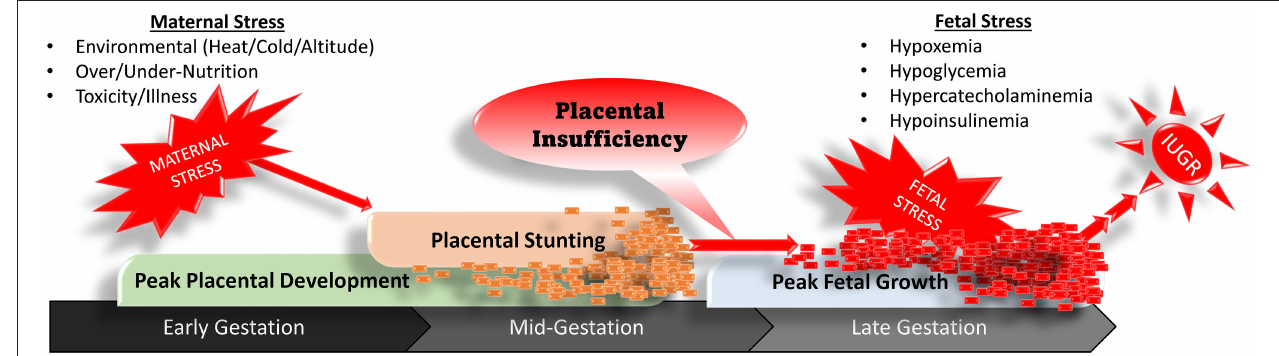
FIGURE 1 | Progression of stress-induced placental stunting in early to mid-gestation that results in placental insufficiency, fetal stress, and intrauterine growth restriction in late gestation.